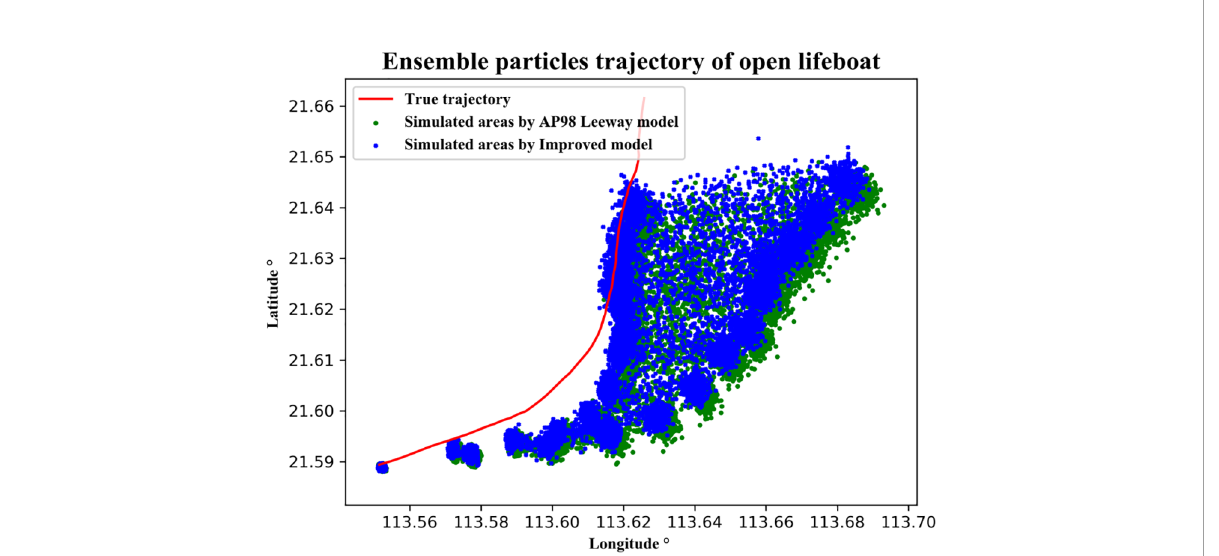
FIGURE 14 Monte Carlo simulation results for Case 2. The random particle distribution of hourly Monte Carlo simulation and the two predicted trajectories after particle averaging. The red line represents the true trajectory, and the two colors of green and black represent the leeway model and the improved model,